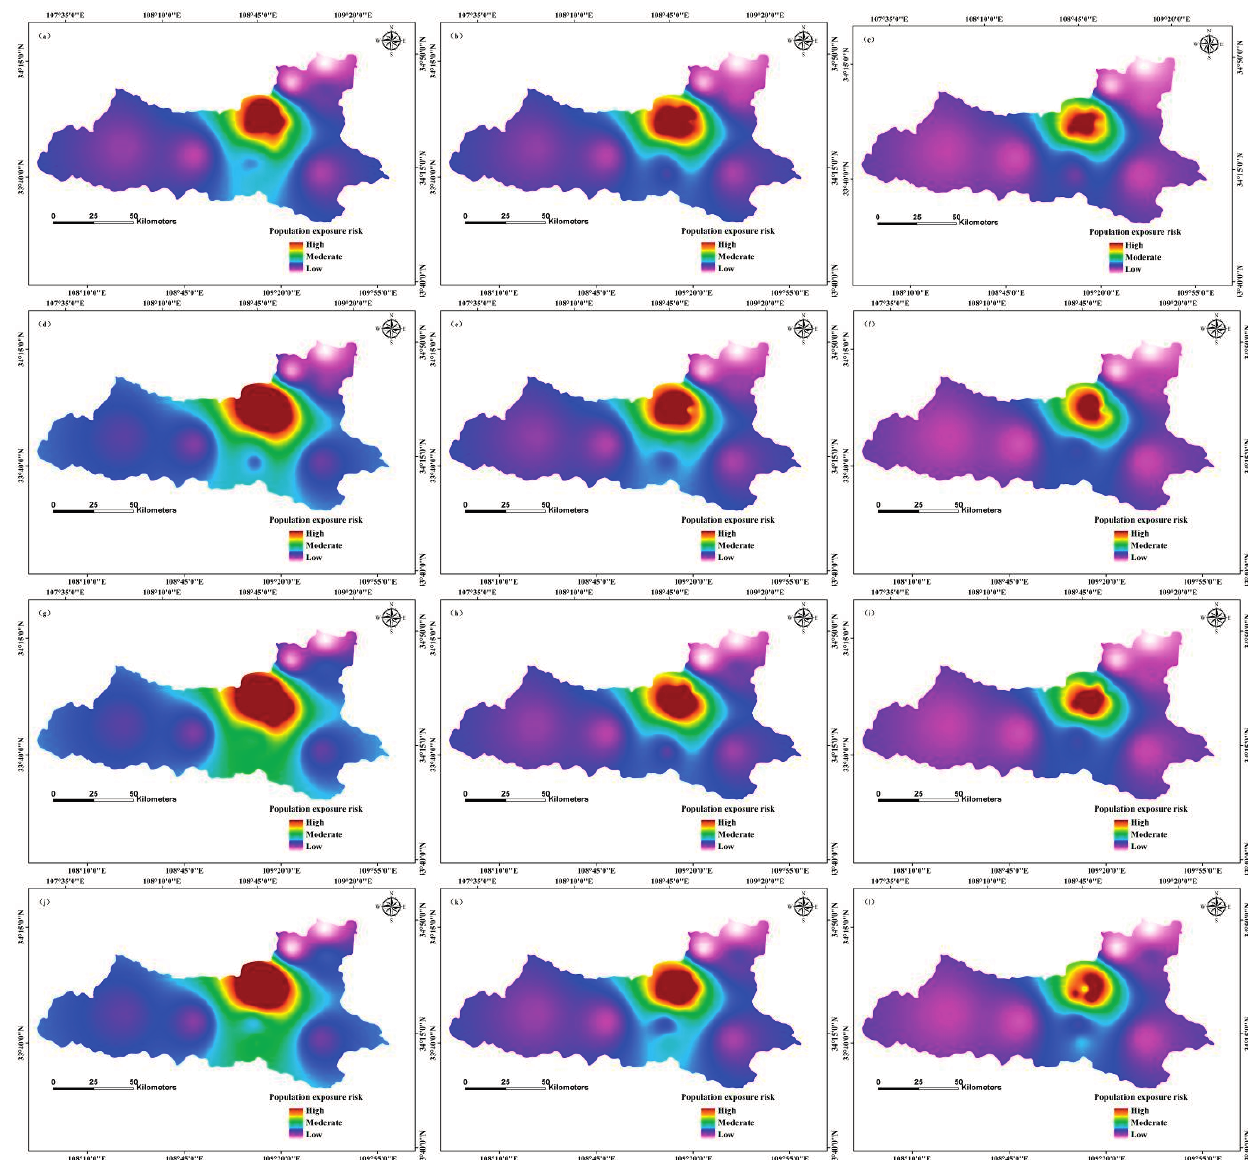
Figure 7. Risk of population exposure to PM2.5 in 2020 in Xi’an, China by month: ( a ) January; ( b ) February; ( c ) March; ( d ) April; ( e ) May; ( f ) June; ( g ) July; ( h ) August; ( i ) September; ( j ) October; ( k ) November; ( l )